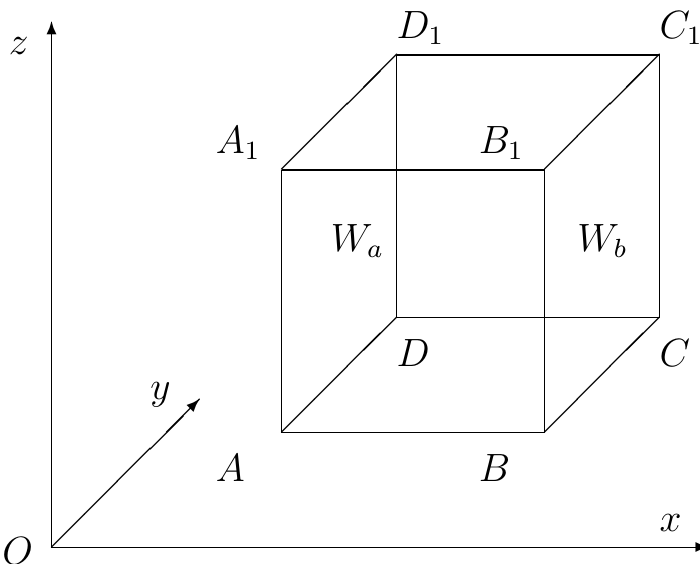
Figure 1. The elementary parallelepiped AB . . . C 1 D 1